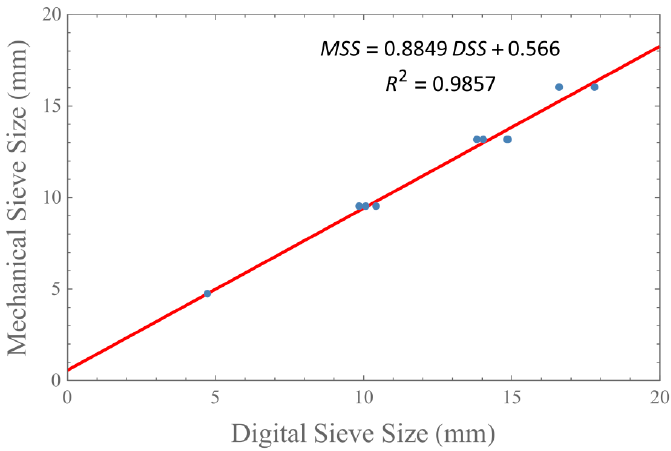
Figure 8. Linear calibration curve for granite.